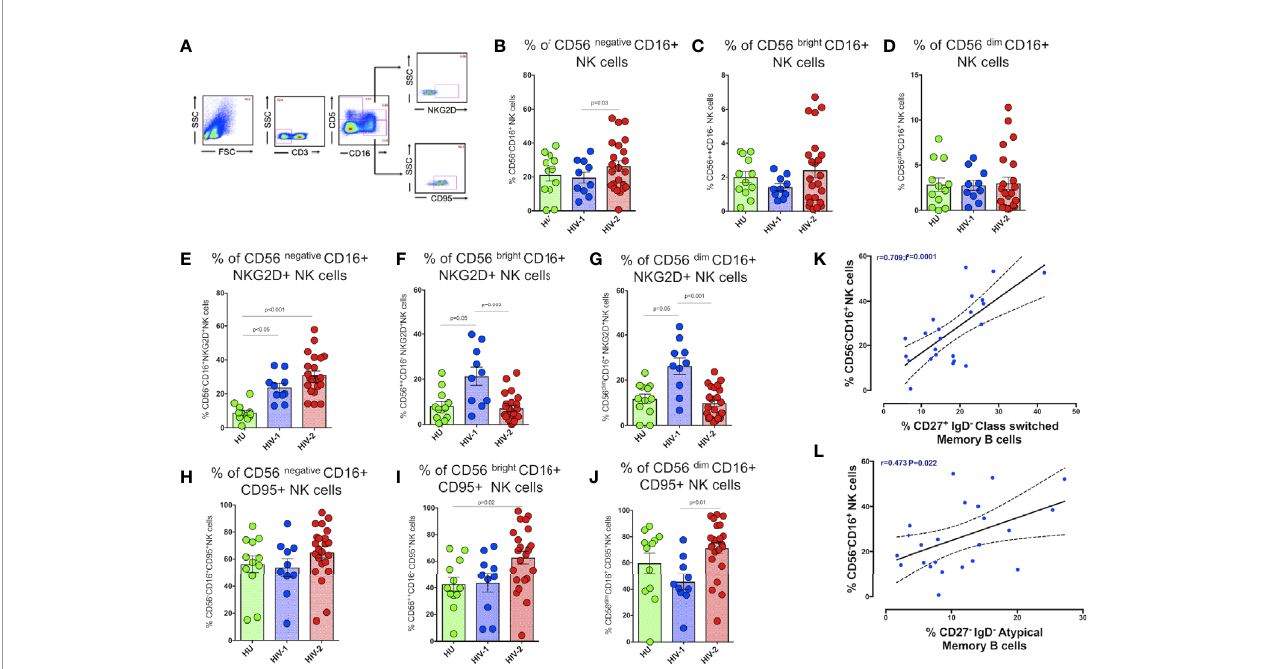
FIGURE 5 | Distribution of NK cell subsets in the study population. (A) Representative fl ow plots showing the enumeration of NK cell subsets based on CD16 and CD56 expression in the study population (HU N=35, HIV-1+ART+ N=10, and HIV-2 N=37). (B) Frequency of CD56 negative CD16+ NK cells in the HU, HIV-1+ART+ and HIV-2 groups. (C) Frequency of CD56 bright CD16+ NK cells in the HU, HIV-1+ART+ and HIV-2 groups. (D) Frequency of CD56 dim CD16+ NK cells in the HU, HIV-1+ART+ and HIV-2 groups. (E) Frequency of CD56 negative CD16+NKG2D+ NK cells in the HU, HIV-1+ART+ and HIV-2 groups. (F) Frequency of CD56 bright CD16+NKG2D+ NK cells in the HU, HIV-1+ART+ and HIV-2 groups. (G) Frequency of CD56 dim CD16+NKG2D+ NK cells in the HU, HIV-1+ART+ and HIV-2 groups. (H) Frequency of CD56 negative CD16+CD95+ NK cells in the HU, HIV-1+ART+ and HIV-2 groups. (I) Frequency of CD56 bright CD16+CD95+ NK cells in the HU, HIV-1+ART+ and HIV-2 groups. (J) Frequency of CD56 dim CD16+95+ NK cells in the HU, HIV-1+ART+ and HIV-2 groups. The scatter dot plots summarize the % frequency of NK cell subsets with differential expression of CD56 and CD16 (median, 1st and 3rd quartiles). P values were calculated using the K- Wallis test. Sub-group analysis was performed using Dunn ’ s test. (K) Correlation between the frequency of CD56 negative CD16+ NK cells and frequency of CD27+ IgD- Class Switched Memory B cells in HIV-2 infected individuals. (L) Correlation between the frequency of CD56 negative CD16+ NK cells and frequency of CD27- IgD- Atypical Memory B cells in HIV-2 infected individuals. (Note: HU: HIV-unexposed seronegative controls; HIV-1+ART+: HIV-1-infected women on ART; HIV-2: HIV-2 infected